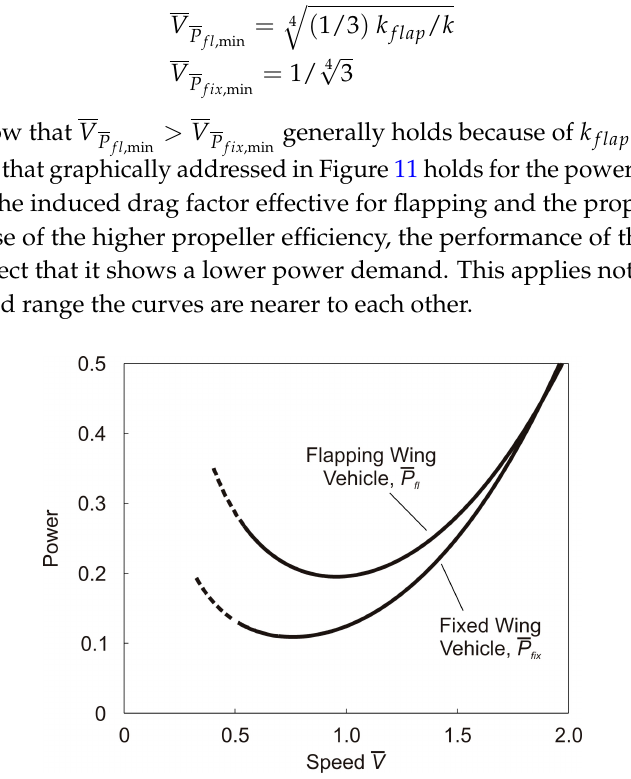
Figure 11. Power required in level flight ( k flap = 2.5, η prop =